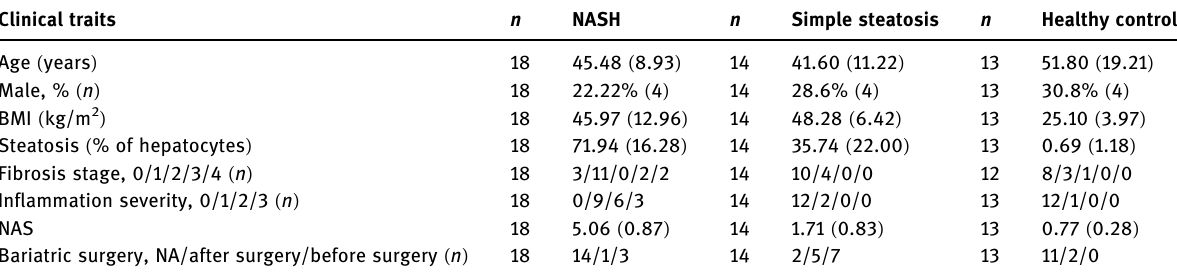
Table A1: Clinical data of dataset GSE48452. Values given are mean ( SD ) or numbers of valid cases Clinical